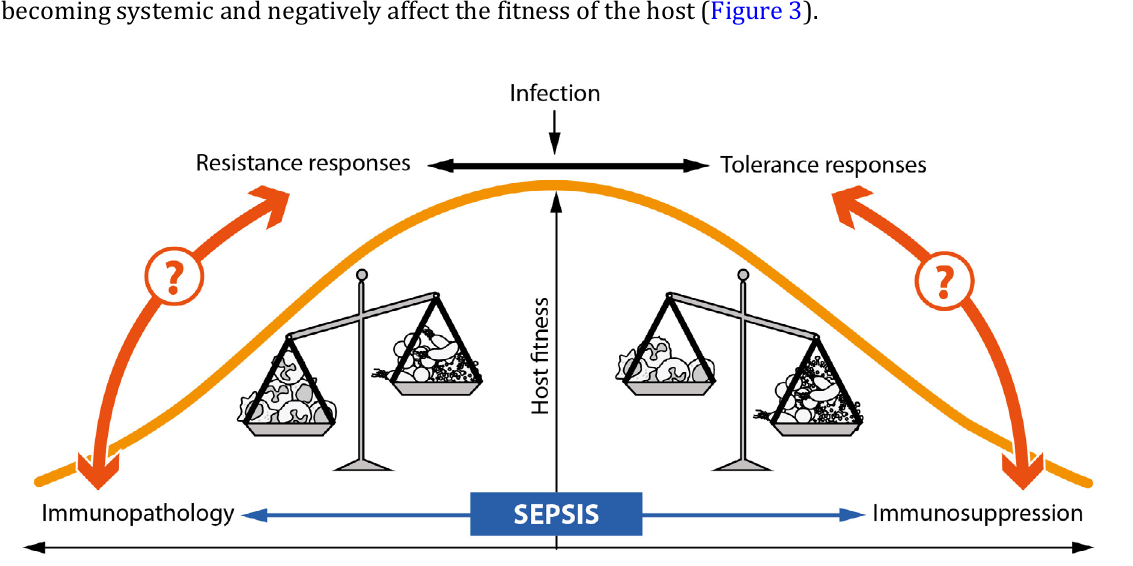
Figure 3. Failing immune responses in sepsis affect host